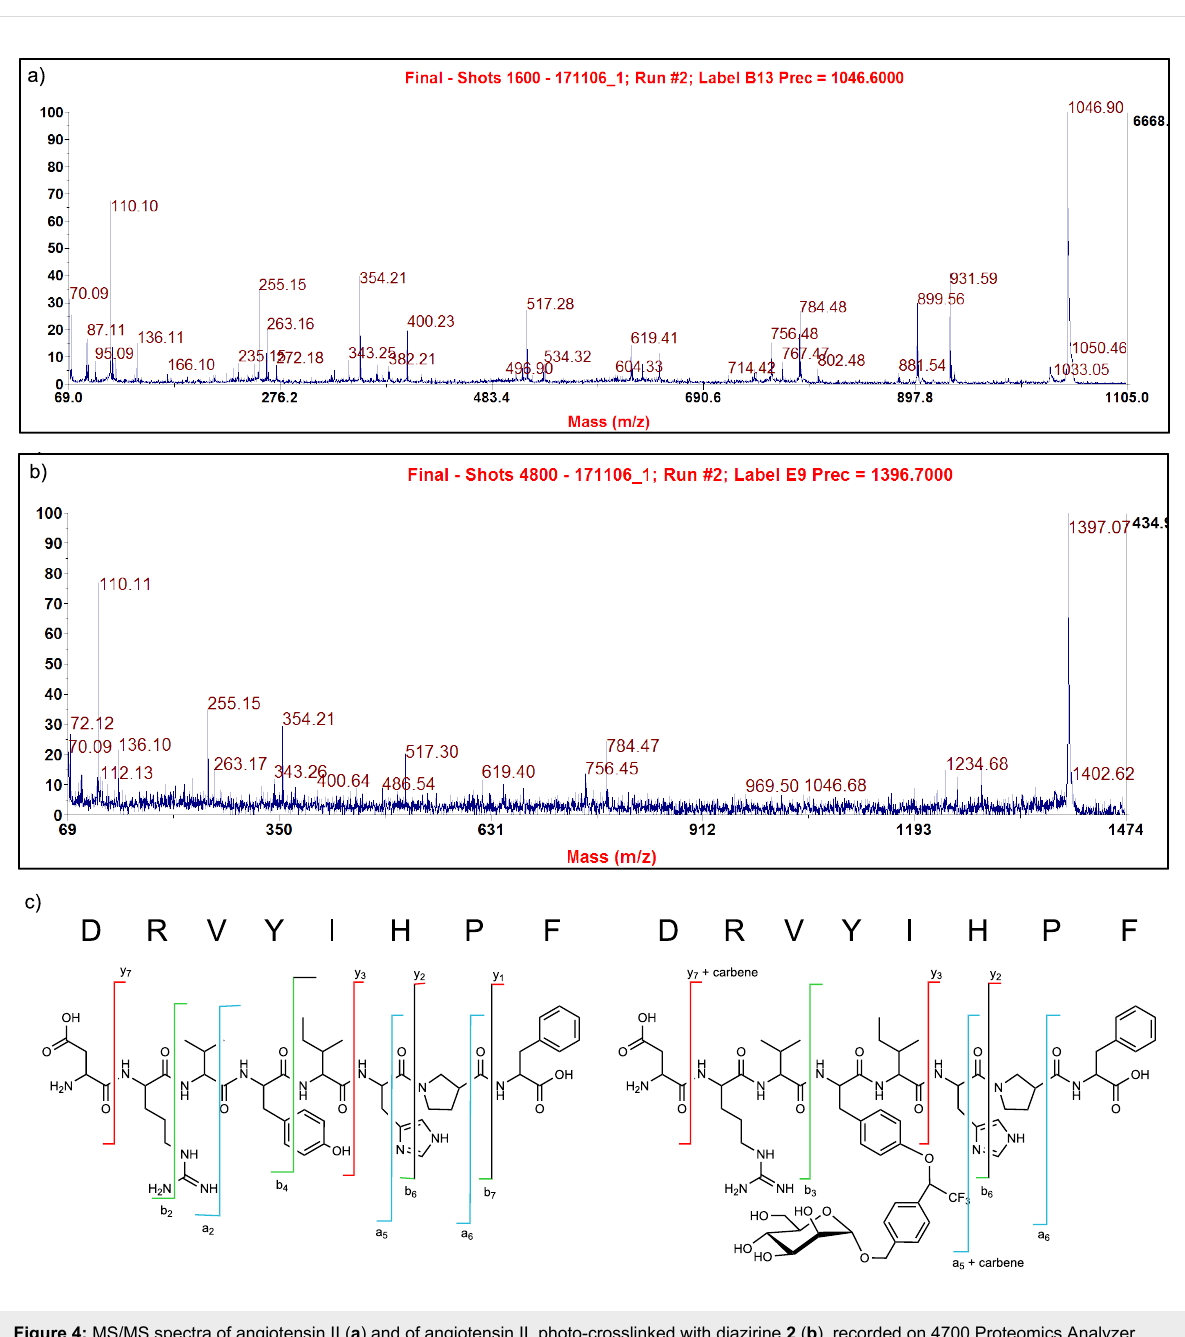
Figure 4: MS/MS spectra of angiotensin II ( a ) and of angiotensin II, photo-crosslinked with diazirine 2 ( b ), recorded on 4700 Proteomics Analyzer mass spectrometer (Applied Biosystems); ( c ) fragments of angiotensin II and photo-crosslinked angiotensin II according to Biemann’s nomenclature (Table